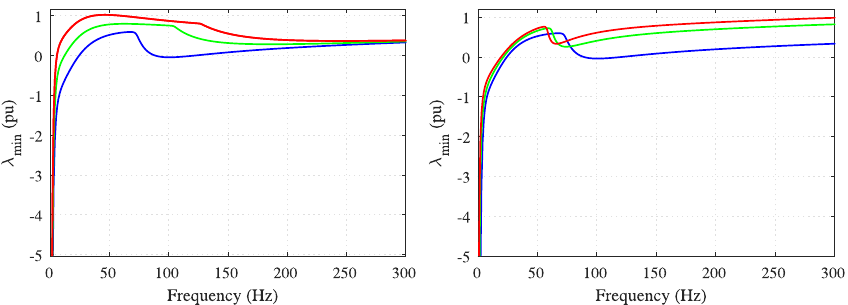
Figure 14. Frequency characteristic of λ (cid:48) L v = 0.2 pu (blue), L v = 0.4 pu (green), and L v = 0.6 pu (red).